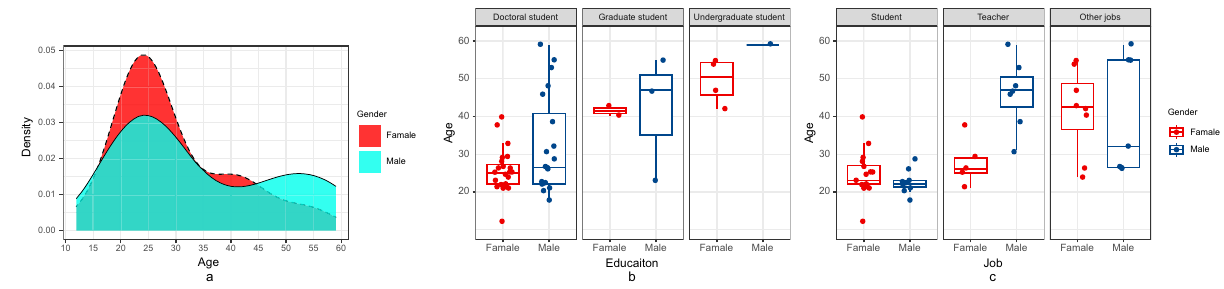
Fig. 4 Age variation was based on different jobs and genders in the eye movement experiment. a The gender characteristics of participants, b The education characteristics of participants, c The occupation characteristics of